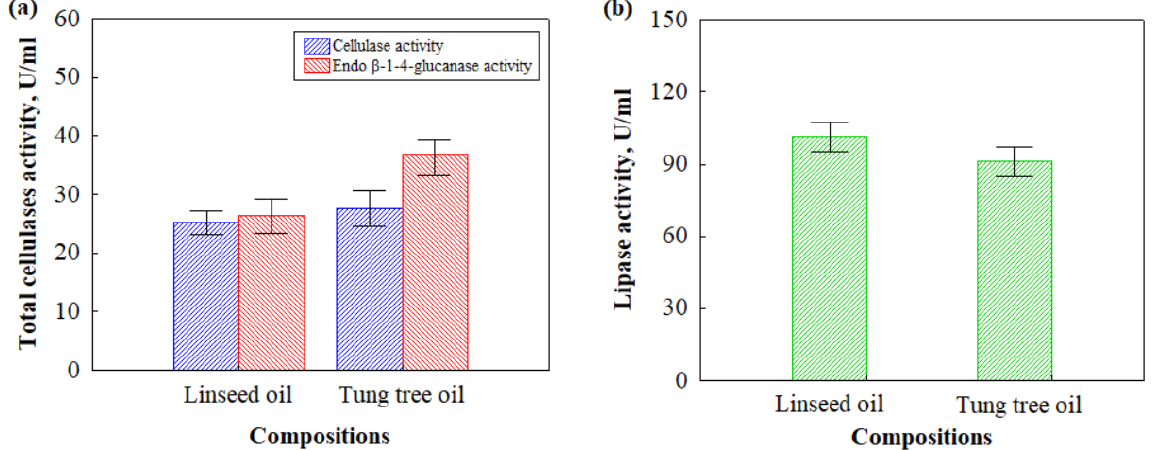
Figure 4. Enzymatic activities of HS- and CS-based biocomposites impregnated with different oils after incubation with microorganisms for 6 months: ( a ) cellulase and endo β -1-4-glucanase activities; ( b ) lipase activity.